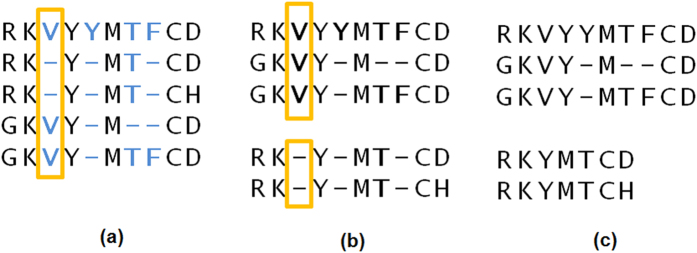
Iteration of column-oriented refinement: (a) one of the candidate columns (in blue) is randomly selected as a splitter (bounded with an orange box); (b) the alignment is divided into two profiles according to the presence of gaps in the selected column; (c) gap-only columns are removed which is followed by profile realignment.